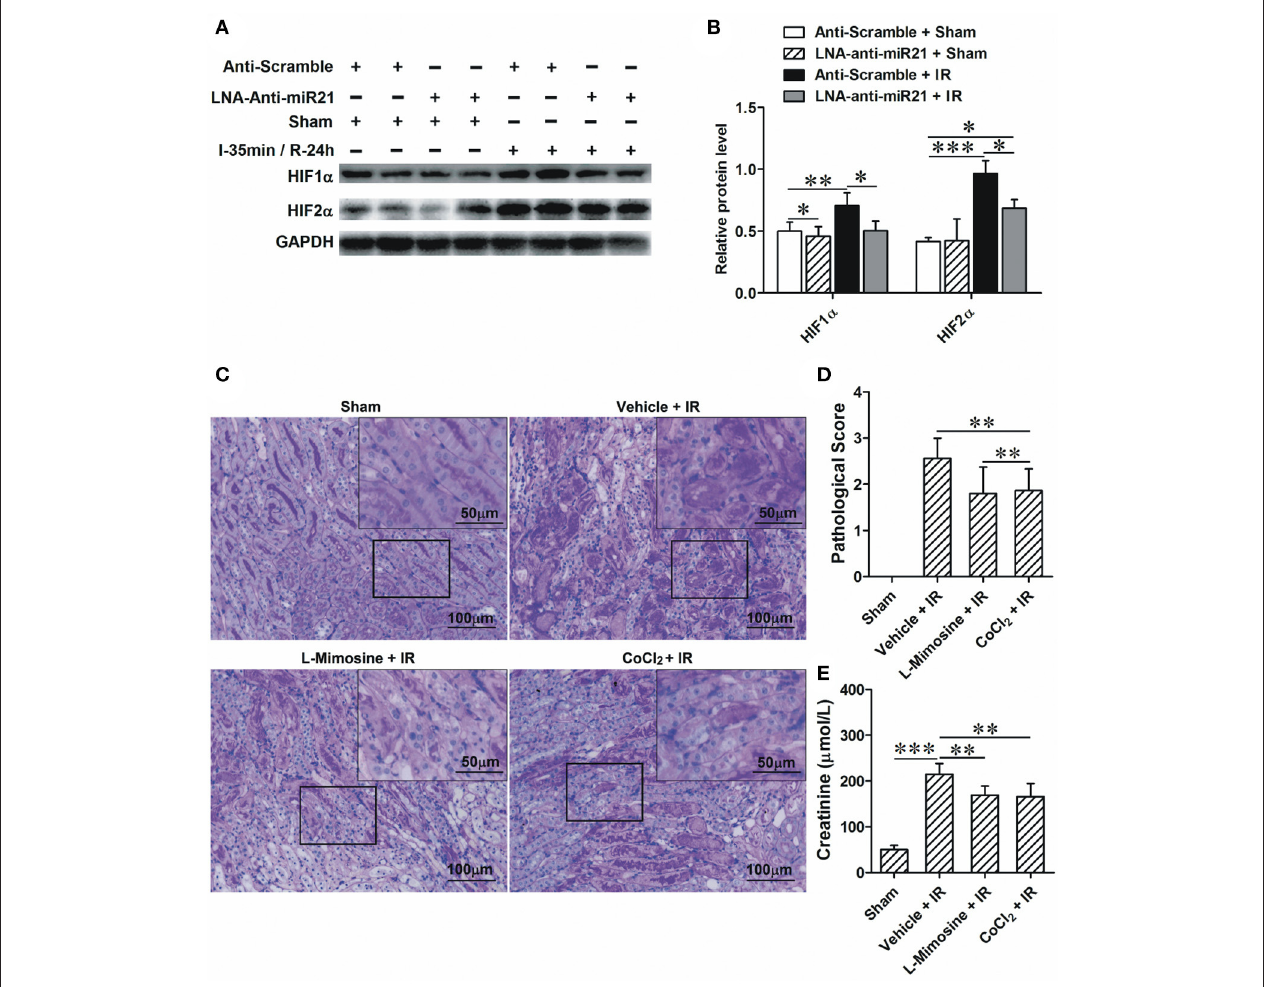
FIGURE 2 | miR-21 regulates IRI by modulating HIF-1 α and HIF-2 α expression. (A) Injection of LNA-modified anti-miR-21 (10 mg/kg) through the tail vein 1h before kidney IR surgery or sham operation. Blocking miR-21 attenuated IR-induced up-regulation of HIF-1 α and HIF-2 α in the kidney. (B) Group data from A . (C) L-Mimosine (50 mg/kg) or CoCl 2 (20 mg/kg) was injected intraperitoneally 1h before kidney IR surgery. PAS staining was performed to access the injury of the kidney. IR-induced kidney damage is mainly presented as epithelial denudation and dilation. The injury is lower in the L-Mimosine or CoCl 2 -treated animals. (D) group data from C . (E) Level of creatinine in the serum. * P < 0.05, ** P < 0.01, *** < 0.001, n =